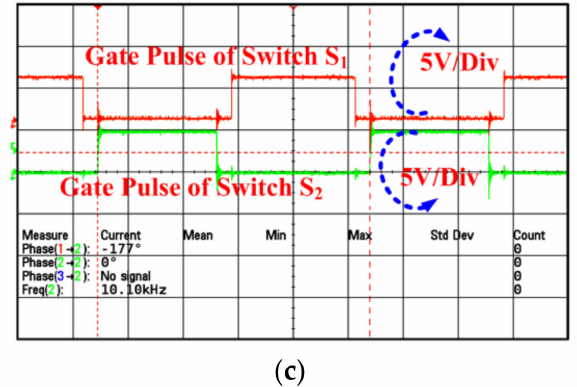
Figure 10. Experimentation Snapshot. ( a ) Proposed FPGA-based PV connected grid-connected transformer-less TNP-MLI. ( b ) Prototype of the TL-TNP-MLI. ( c ) The PWM pulses for top and bottom switches (S1 and S4).